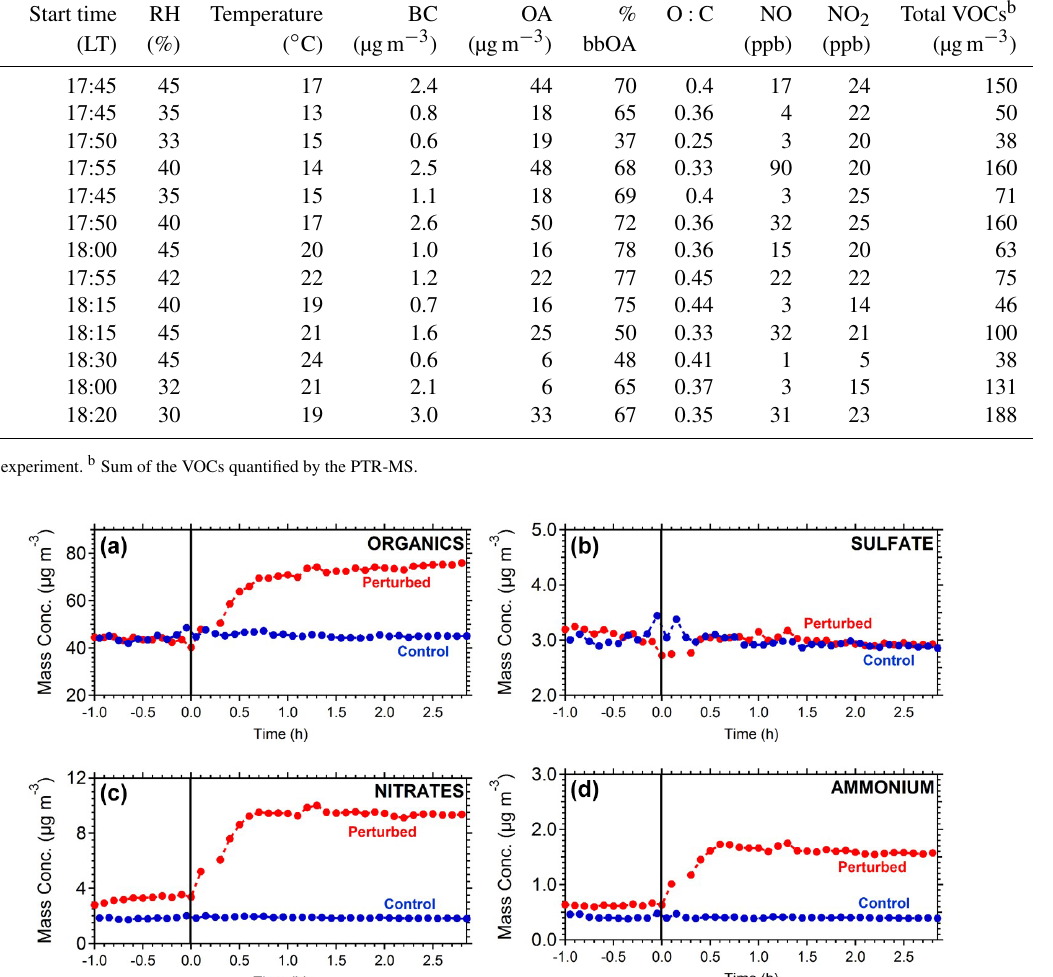
Table 1. Initial conditions for the dual-chamber experiments. Exp. Start time RH